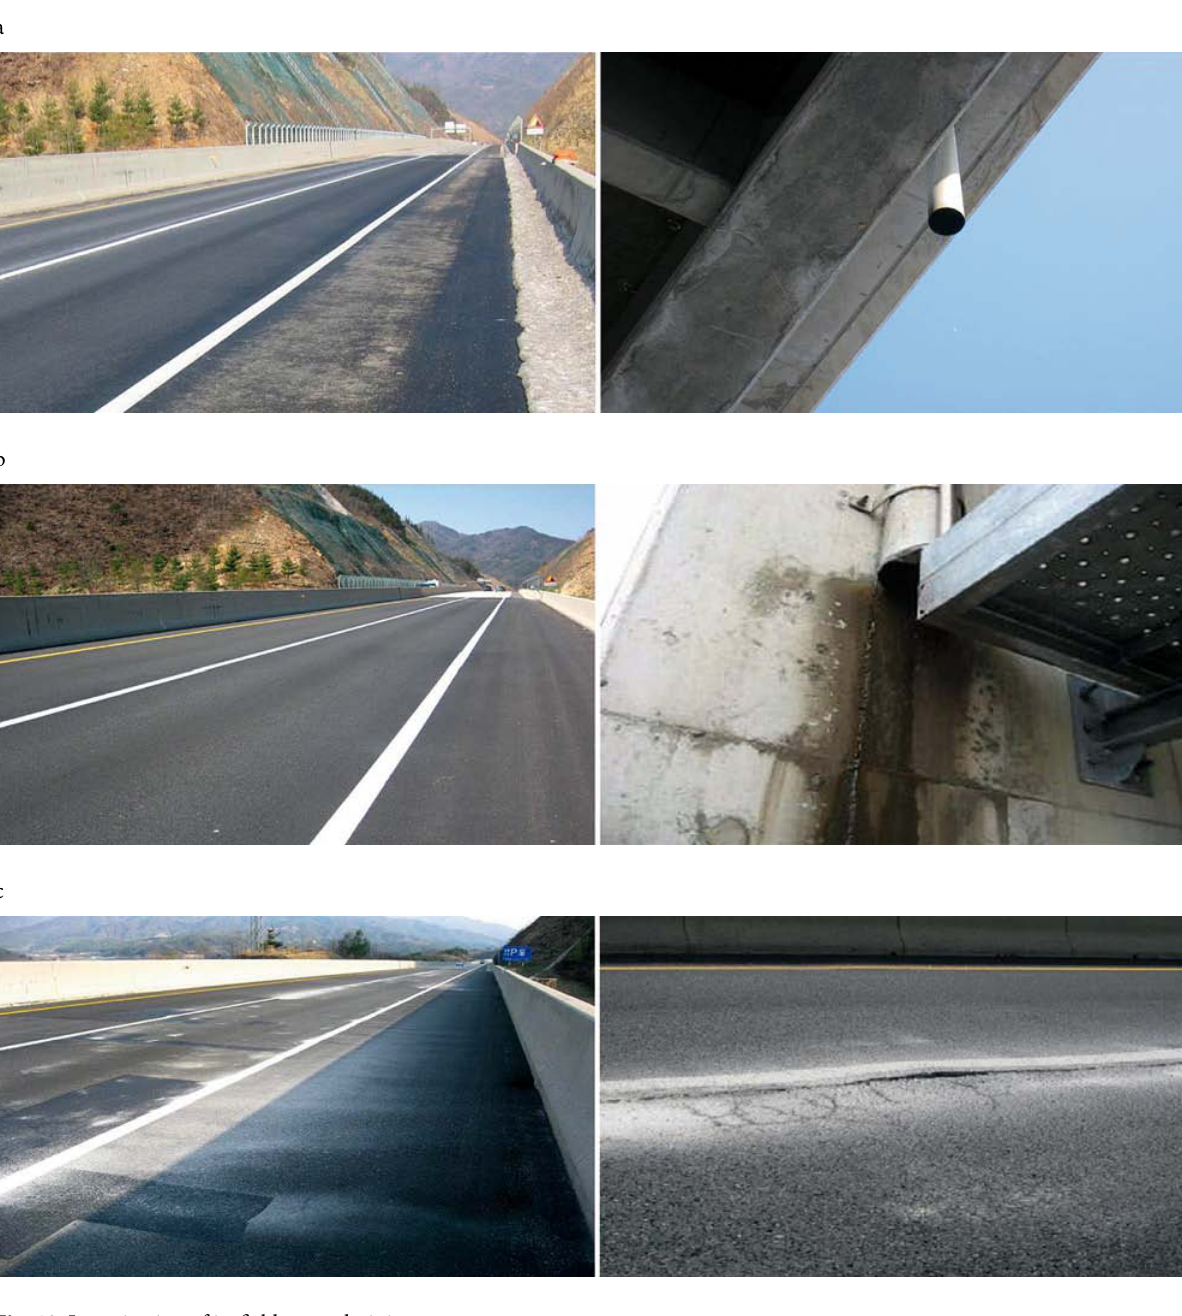
Fig. 10. Investigation of in-field water draining: a – after 3 months (January 2007) with the new drainage system; b – after 20 months (June 2008) with the new drainage system; c – after 20 months (June 2008) with the traditional bridge deck paving